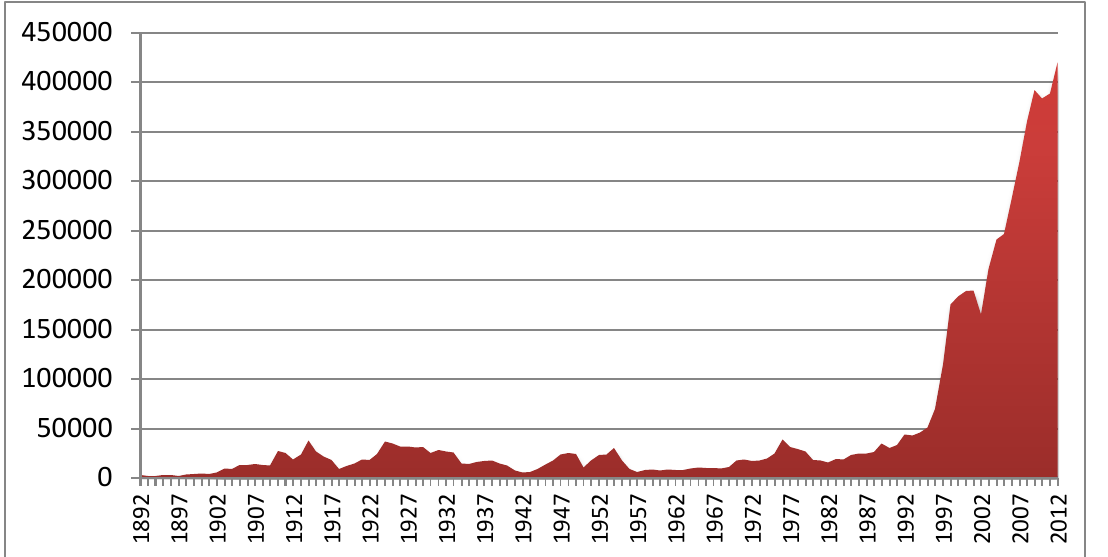
Figure 1: Removals from the United States, 1892-2012